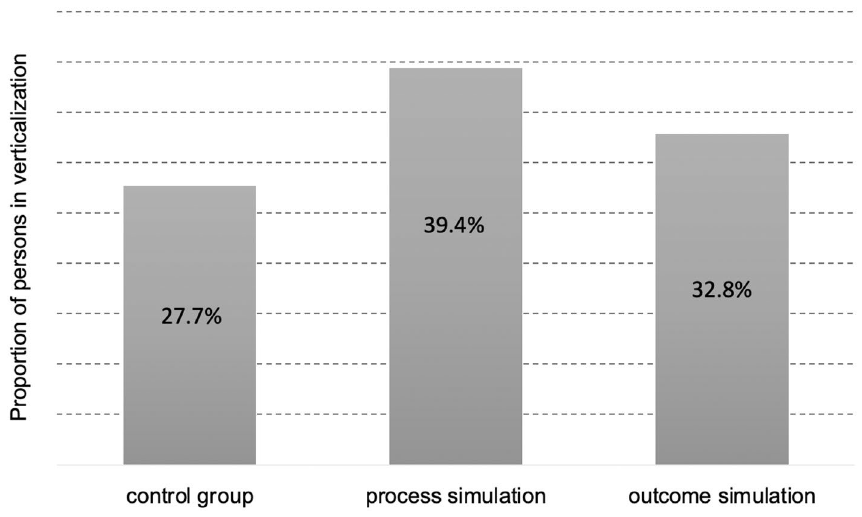
Figure 1. A proportion of verticalized patients in the control, process-simulation, and outcome-simulation